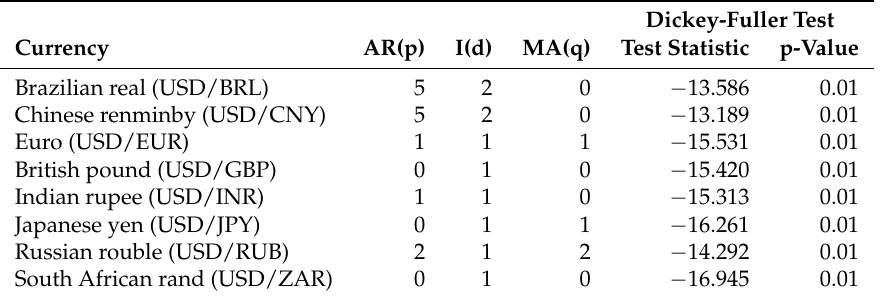
Table 2. Parameters for the ARIMA model, and observed valued of the test statistic and p-values for the Dickey-Fuller test.